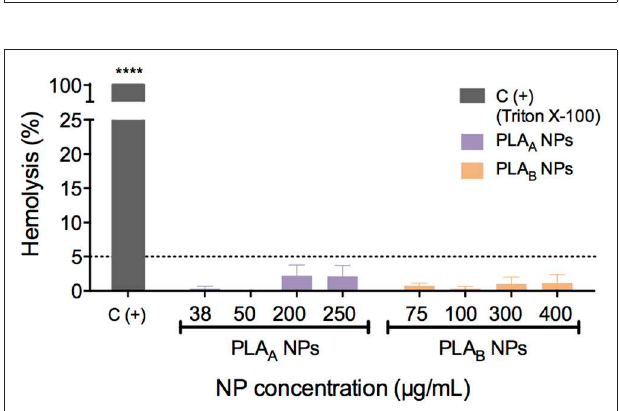
FIGURE 3 | Hemolytic activity of PLA NPs in human blood after 3h of incubation at 37 ◦ C. Triton X-100 was used as a positive control. Hemolytic values were considered above 5%, as recommended by American Society for Testing and Materials International (ASTM, 2013). Data are presented as mean ± SEM, n ≥ 3 (three or more independent experiments, each in duplicate). **** p < 0.0001 indicates values that differ significantly from negative control